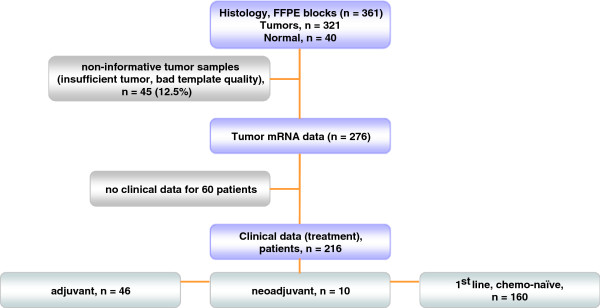
REMARK diagram of the tumors and patient populations studied.